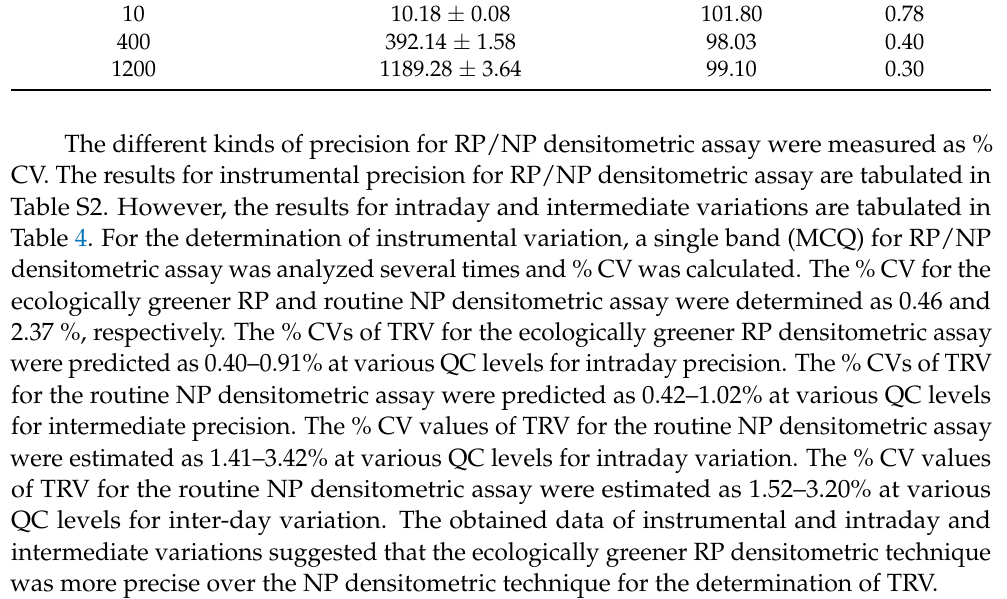
Table 4. Measurement of intra/inter-day precision of TRV for R-NP-HPTLC and G-RP-HPTLC methods (mean ± SD; n = 6).